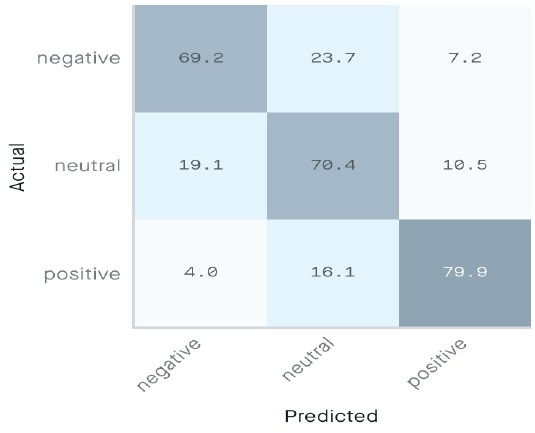
Figure 10. Confusion matrix of sentiment classifier using mBERT.